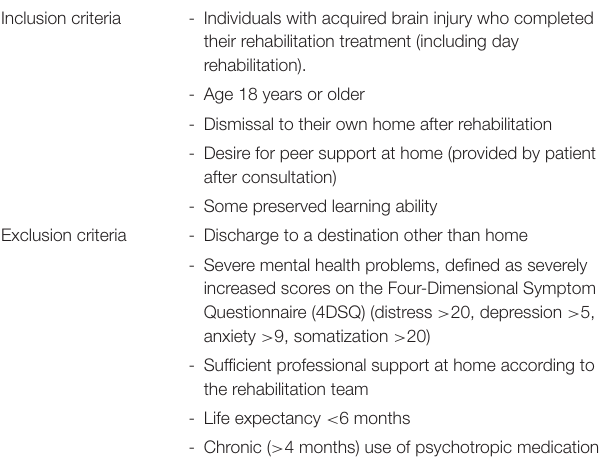
TABLE 1 | Inclusion and exclusion criteria for patients. Inclusion